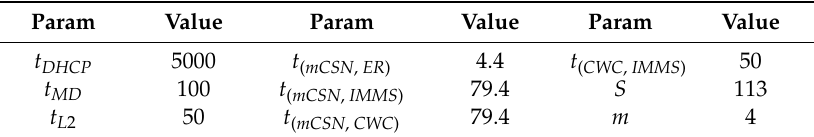
Table 1. Parameters for delay analysis (Kbps, ms, bytes).